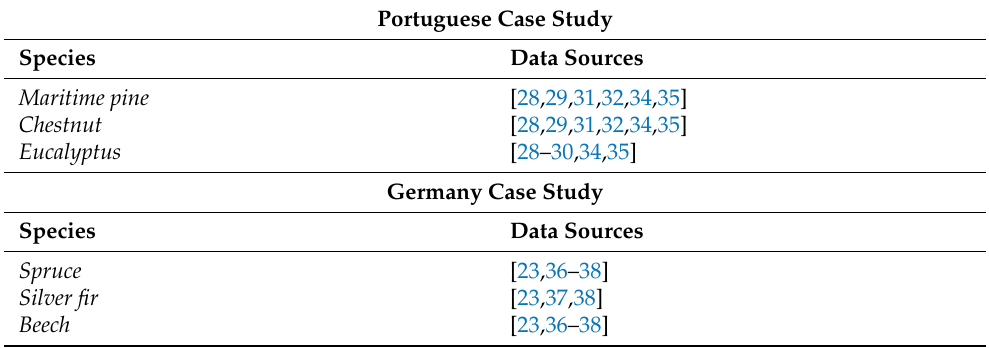
Table 1. List of species and data sources used for our